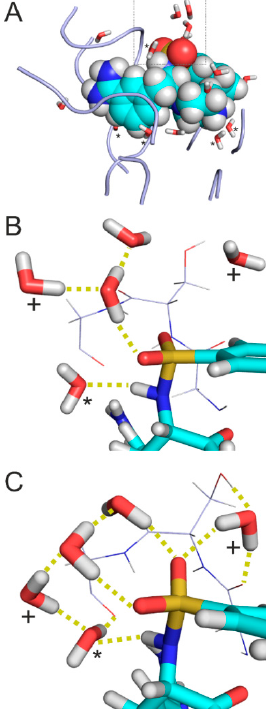
Figure 3. Extracted complex interface of System 1k1l. ( A ) Initial structure equipped with water molecules and energy-minimized at the molecular mechanics level. Target fragments and ligand are shown in ribbon and space filling representations, respectively. Water molecules in Shell 1 (d W = 3.5 Å, sticks marked with asterisk) are positioned close to the solute partners and play a bridging role. The rest of Shell 3 (d W = 5.0 Å) waters belong to Shell 2 (sticks without asterisks) and located at the edges of the interface, close to the bulk. Shell 3 = Shell 1 + Shell 2. ( B ) A rotated close-up of the box in Panel A showing the surrounding of the sulphonyl group of the ligand (sticks) and the neighboring residues G 216 SG 218 of the target (lines) where the numbering follows that of the crystallographic structure (PDB ID 1k1l). Hydrogen bonds are marked with yellow dotted lines. ( C ) Structure in Panel B after relaxation at semi-empirical level using PM7 parameterization and Mozyme. Water molecules with a displacement above 1.5 Å after relaxation are marked with crosses.